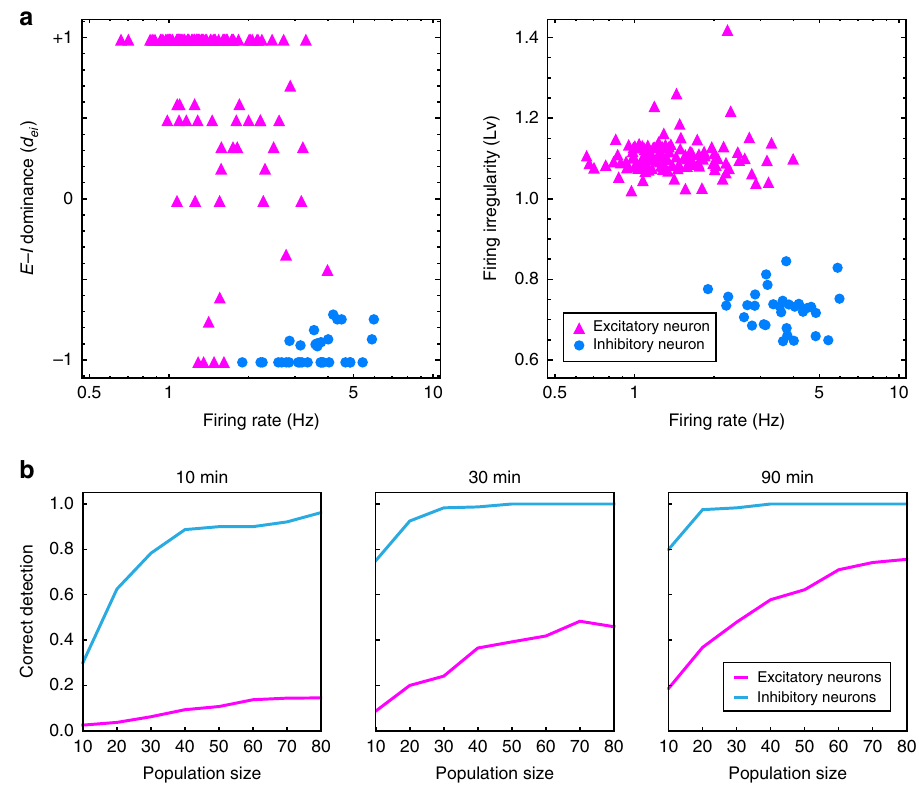
= ð n n n n and the fi ring irregularity ( Lv ), plotted against the ei ¼ ð e (cid:2) i Þ e þ i Þ 0 and d 0, respectively for ei > ei <